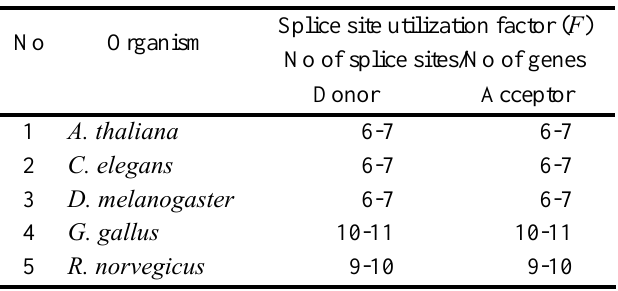
Table 2. Splice site utilization factor of the organisms